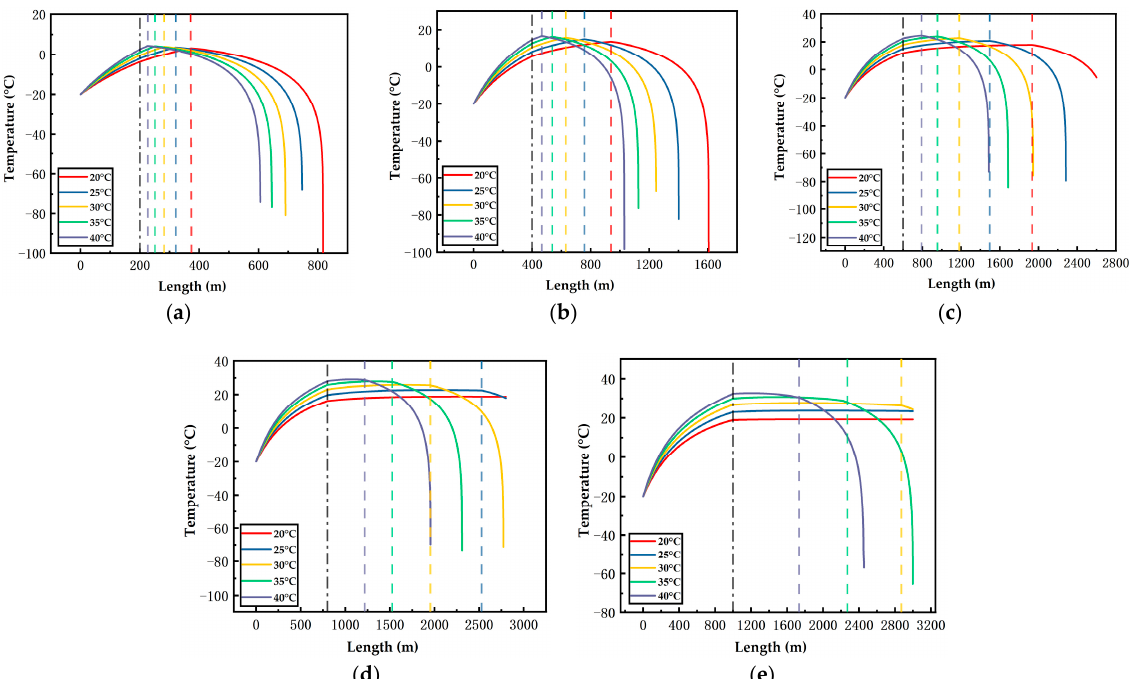
Figure 7. Variation of the on-way temperature with the length at 7.5 m/s airflow velocity, different ambient temperatures and depths (( a ) 200 m; ( b ) 400 m; ( c ) 600 m; ( d ) 800 m; ( e ) 1000 m). The black dotted line indicates the connection between the vertical pipe and the underground pipe; The dotted lines in other colors represent gasification points.